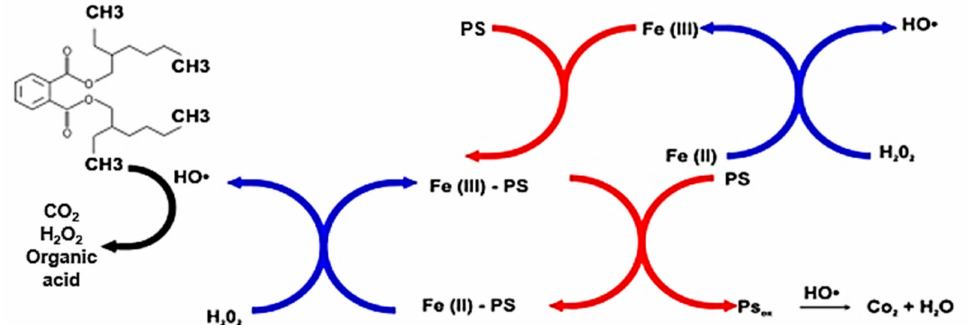
Figure 3. Mechanism of action of PS in the modified Fenton process [developed on the basis of Zhao et al. (2018)